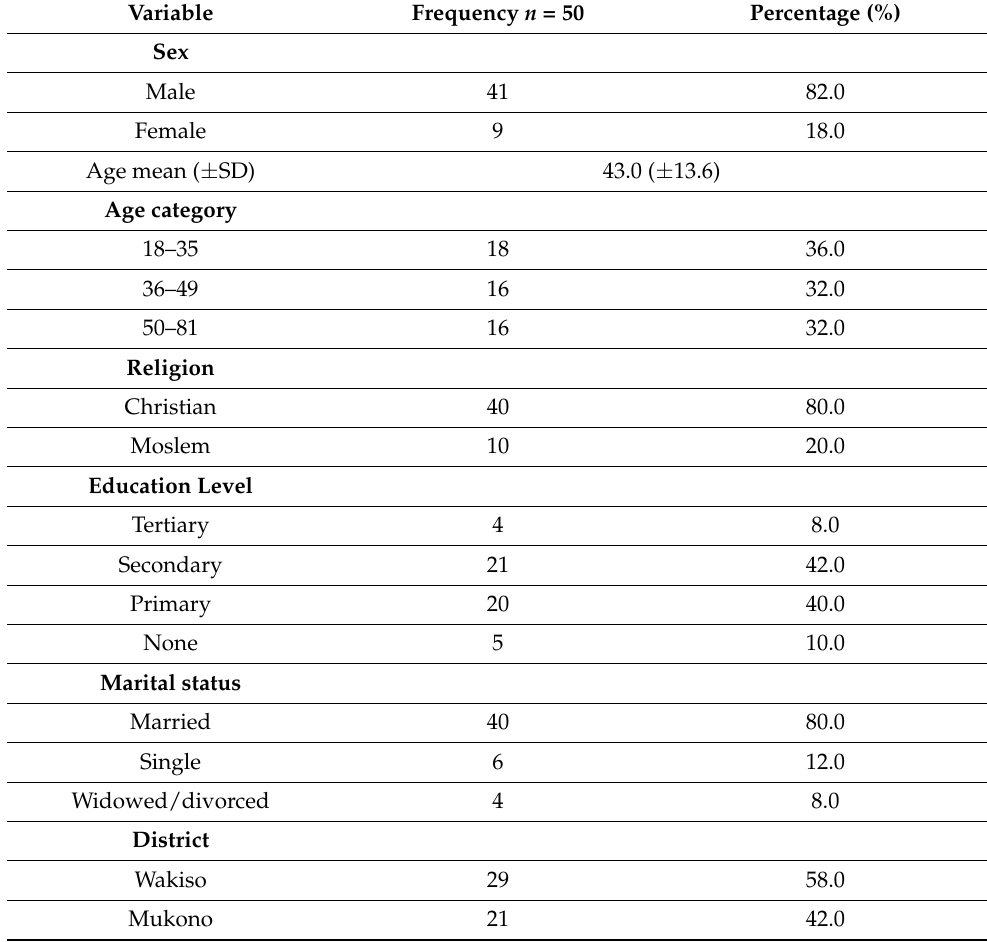
Table 1. Sociodemographic characteristics of